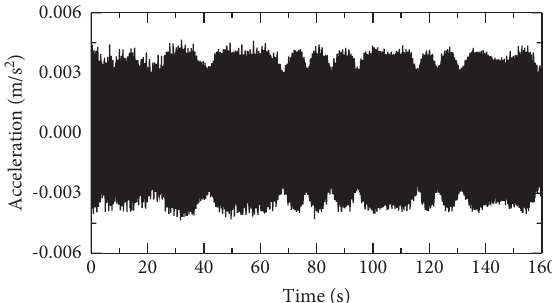
Figure 5: Bridge acceleration at reference point 23 under ambient